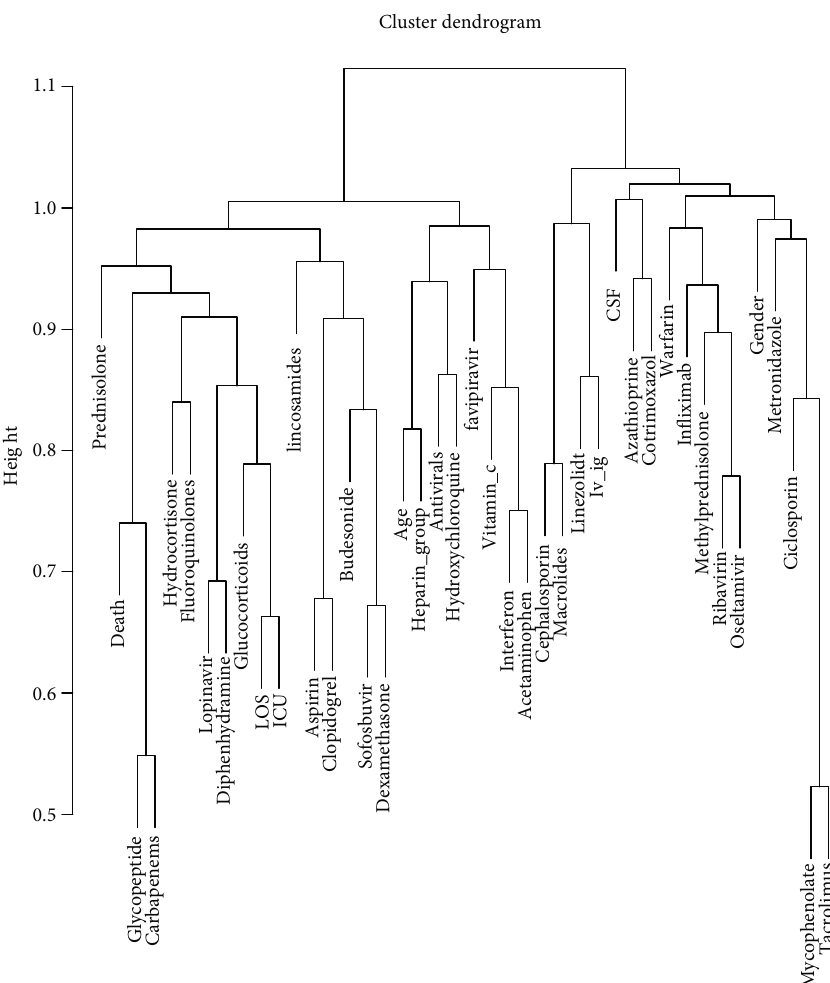
Figure 2: Dendrogram for association rule